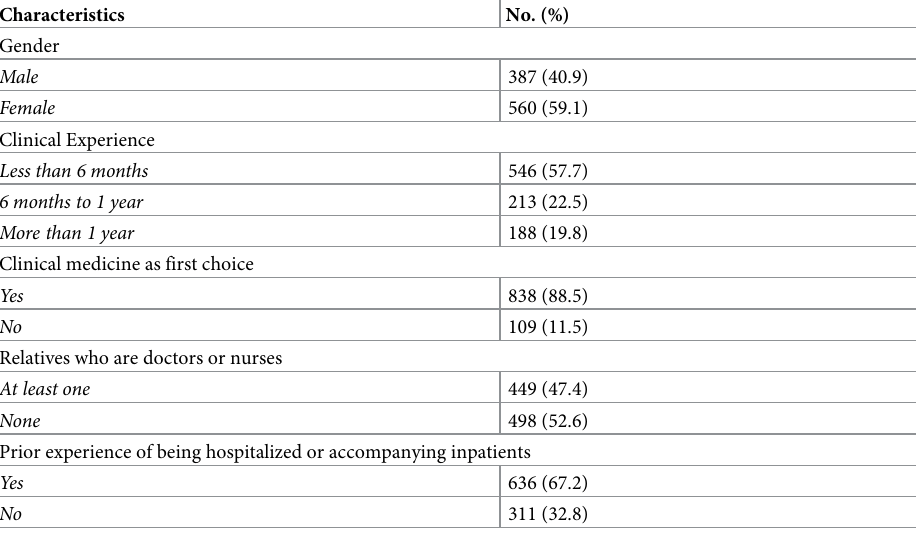
Table 1. Demographic characteristics of the 947 surveyed medical